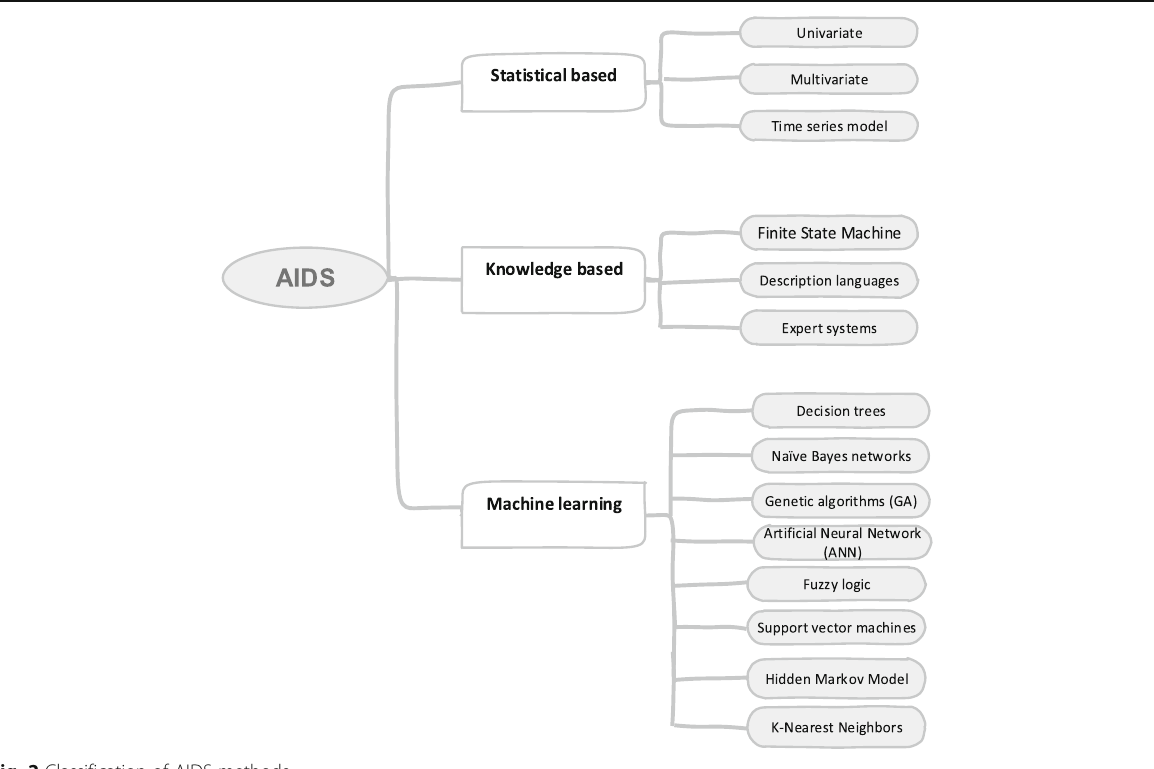
Fig. 2 Classification of AIDS